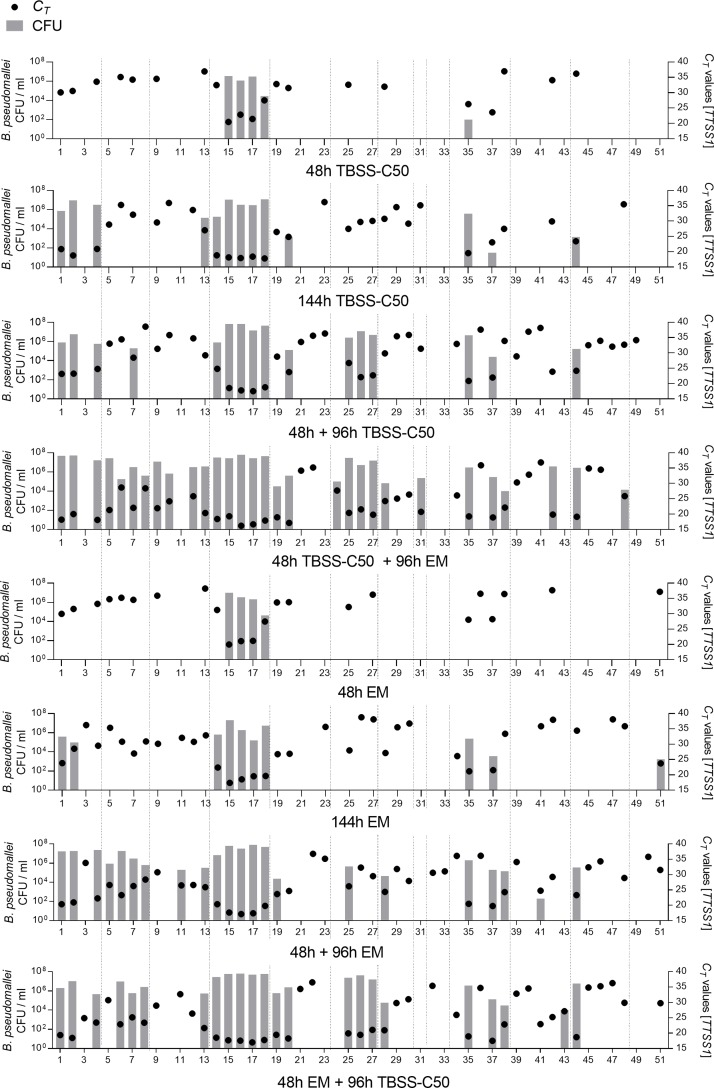
Impact of the various enrichment methods on the B. pseudomallei load and subsequent recovery on Ashdown agar in single samples.From 80 soil samples incubated under eight different culture conditions using TBSS-C50 and the erythritol containing EM broth, 51 soil samples gave a positive qPCR signal in at least one enrichment. All supernatants of the different culture conditions from these 51 soil samples were subcultured on Ashdown agar at the end of the respective incubation time. Dotted vertical lines frame the soil samples of the same rice field. A single graph combines the data of all soil samples cultured under one respective culture condition. Colony counts of B. pseudomallei are log10-transformed and plotted as bars (refer to left Y axis). Counts were calculated as geometric means of duplicates cultured from each supernatant. Corresponding cycle threshold (CT) values for each culture condition are visualized as dots within the bars (right Y axis).